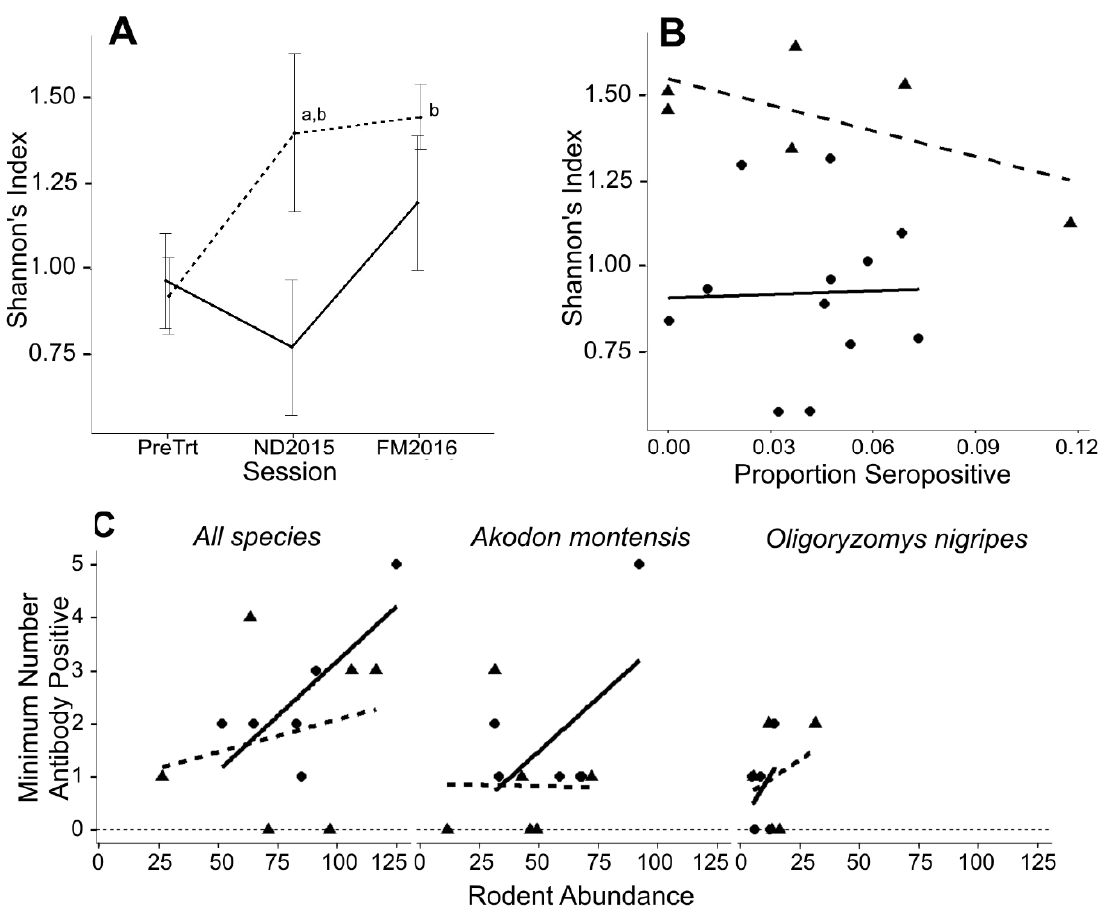
Figure 3. The effects of resource augmentation on species diversity, rodent abundance, and seroprevalence. ( A ) Following the pre-treatment sampling period (PreTrt), resources were added to three of the six grids and rodents were sampled twice: post-treatment sampling by MRR, ND2015, and post-treatment sampling by capture, FM2016. Shannon’s index was calculated based on all unique captures per grid, per sampling period. (a) Diversity on treated grids (triangles and dashed lines) was significantly higher than control grids (circles and solid lines) at the first post-treatment sampling session, ND2015; and (b) diversity on treated grids was significantly higher during both post-treatment sampling sessions compared to pre-treatment sampling session. ( B ) There was no relationship between species diversity and seroprevalence on untreated (circles, solid least squares line) or on treated grids (triangles, dashed least squares line), as a test of the dilution effect. ( C ) There was no statistically significant association between the estimated rodent abundance based on MRR and seroprevalence for all species, or for the two principal reservoir species, Akodon montensis and Oligoryzomys nigripes (symbols and lines follow panel B).